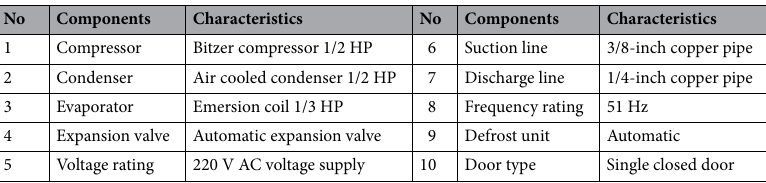
Table 1. Technical details of the experimental system.